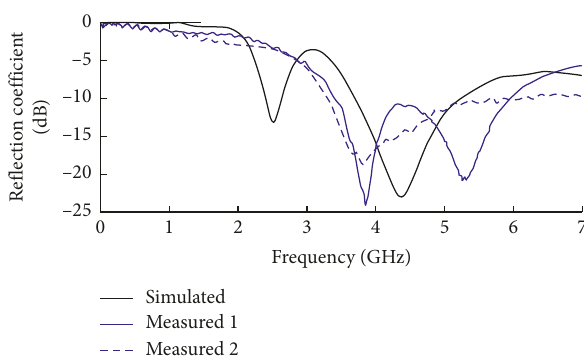
Figure 11: Measured reflection coefficient in free-space of the reflector-backed